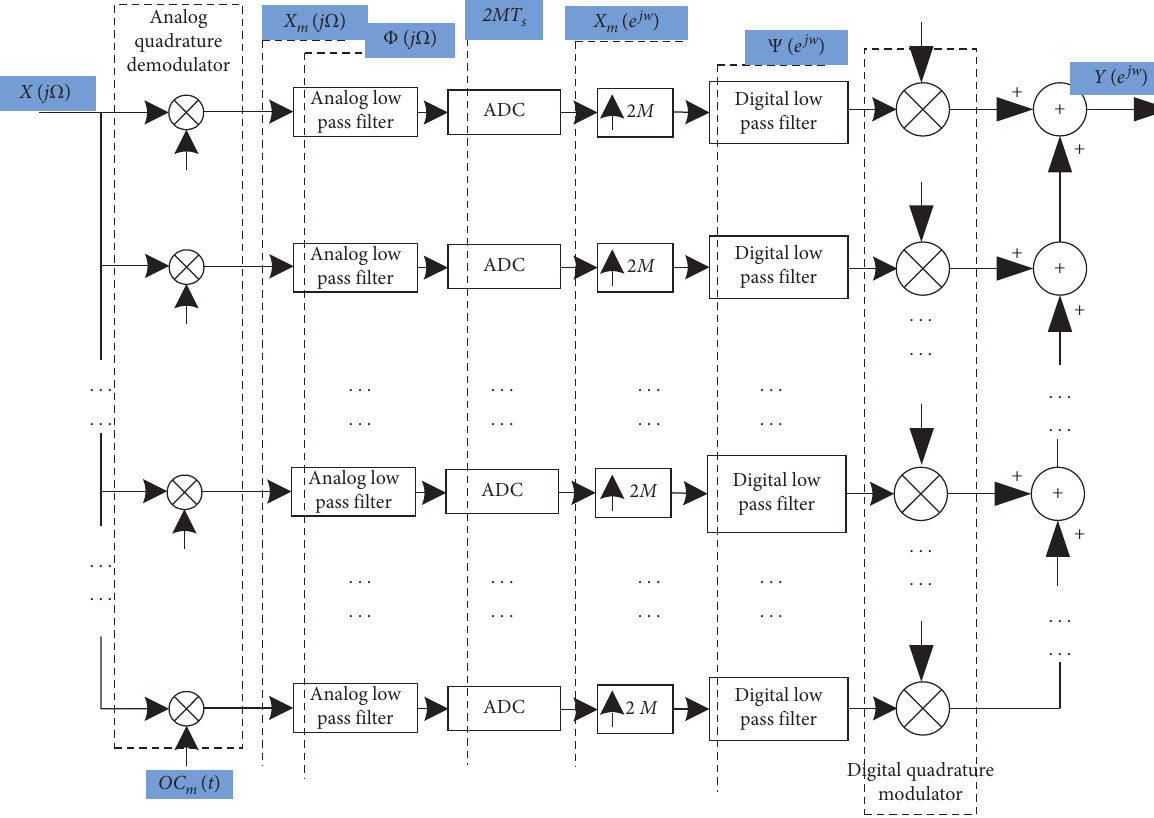
Figure 1: Principle of orthogonal frequency alternating acquisition